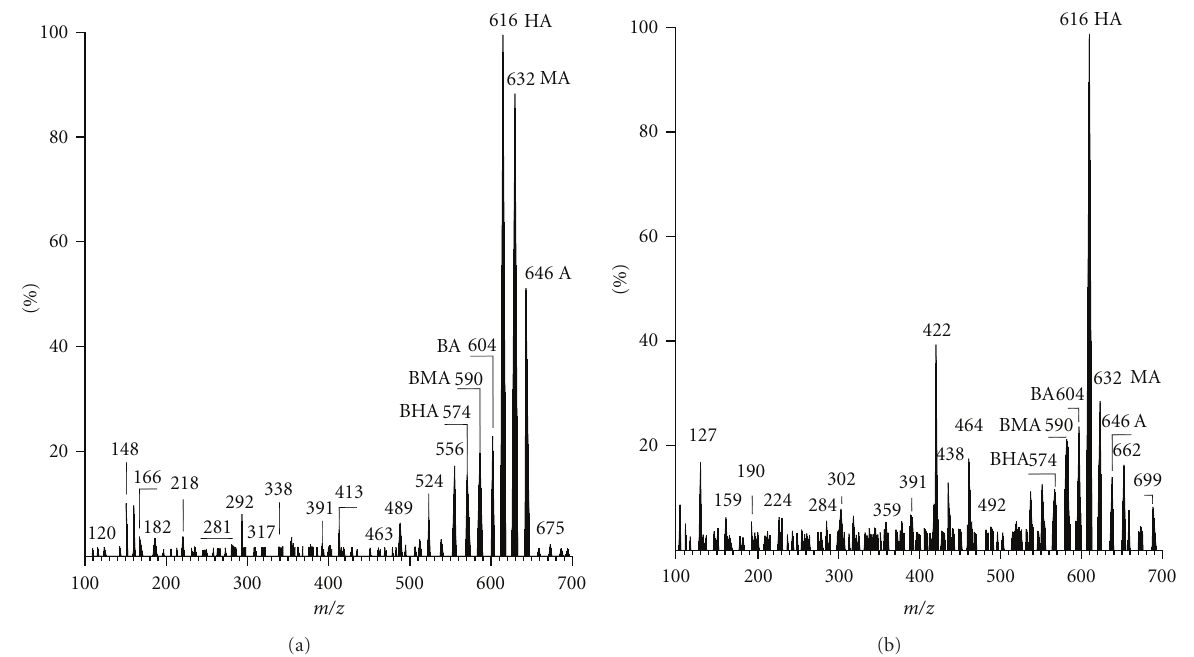
Figure 4: The ESI/MS spectra of (a) the mixture of A, MA, and HA standards at 1 µ g/mL level; (b) the decocted Chuanwu (the time of decoction was 0.5h).